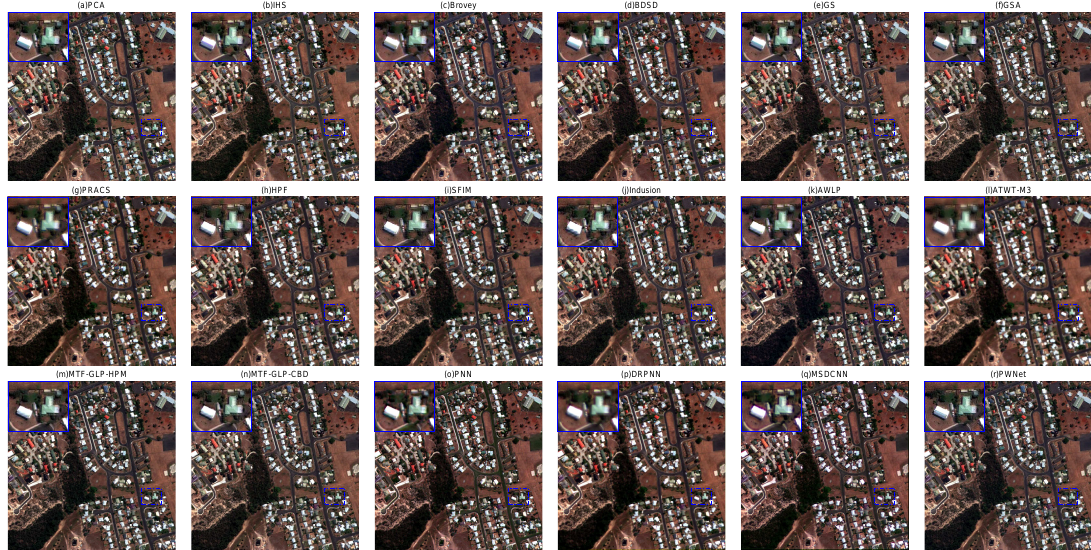
Figure 15. Visual comparison of different methods on the GeoEye-1 data set at full resolution, ( a ) PCA; ( b ) GIHS; ( c ) Brovey; ( d ) BDSD; ( e ) GS; ( f ) GSA; ( g ) PRACS; ( h ) HPF; ( i ) SFIM; ( j ) Indusion; ( k ) AWLP; ( l ) ATWT-M3; ( m ) MTF-GLP-HPM; ( n ) MTF-GLP-CBD; ( o ) PNN; ( p ) DRPNN; ( q ) MSDCNN; ( r ) PWNet